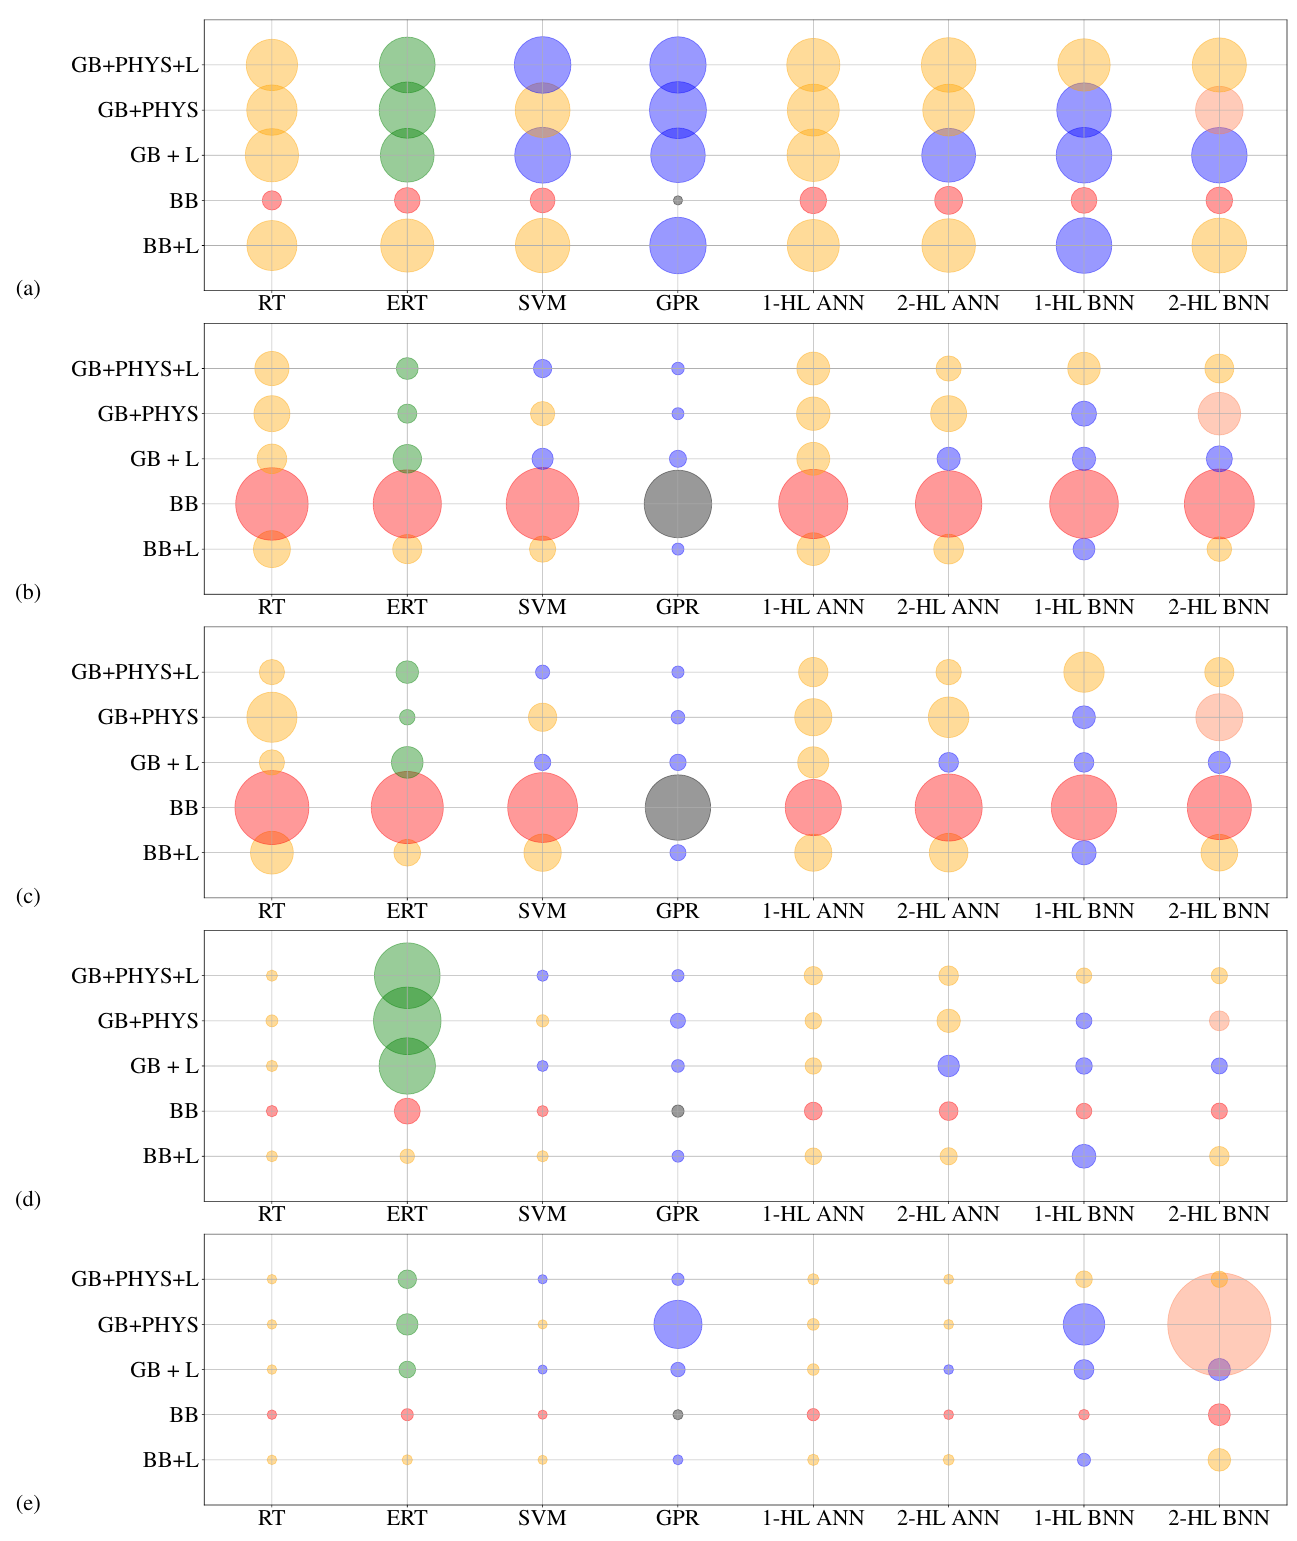
Figure 9. First filter clustering of models using K-means algorithm: 40 models divided to 6 clusters and sorted based on ( a ) R 2 test , ( b ) RMSE test [ mg/m 3 ] , ( c )